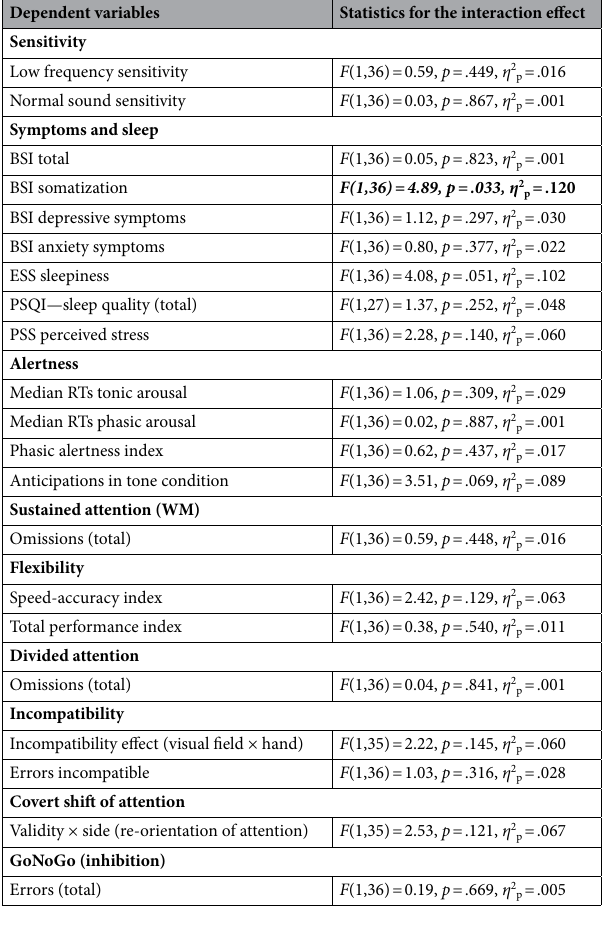
Table 2. Results (group x time interaction effects) of the repeated measures ANOVAs for all behavioral variables. Alpha level = 0.05; Bonferroni-adjusted = 0.05/21 = 0.024. After application of the corrected p -level, the significant effect (with unadjusted level, highlighted in bold in Table 2) would not remain. The likelihood of by chance detecting a significant result is 5%, with 21 tests this equals 1.05 tests that would be detected as significant by pure